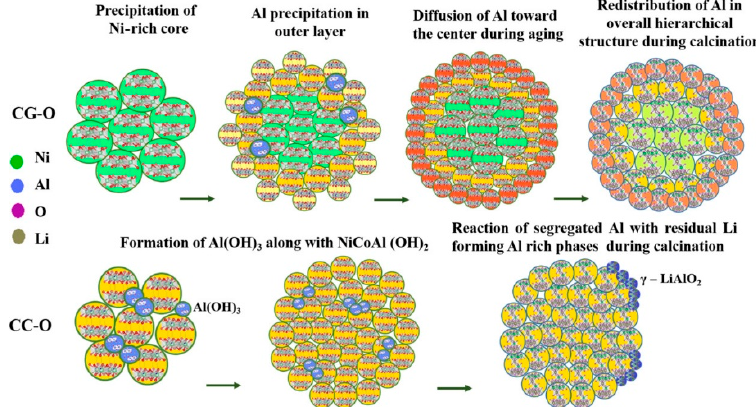
Figure 5. Schematic representation of various stages in the formation of LiNi 0.8 Co 0.135 Al 0.065 O 2 particles CC-O (compositionally constant) and CG-O (compositionally constant core with the graded surface) during the precipitation and high-temperature calcination. Reproduced with permission from [144].